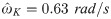
Evolution and statistics of phase metrics for two NA oscillators being (A) in- and (B) anti-phase synchronized.(a, b, h, i) Phase differences Δθ1,2(t), (black) and ϕ1,2(t), (red and magenta for significant PLV, and blue otherwise) with top plots zooming the shaded interval of the lower plots. (c, j) PLV (blue) and its mean value (black), and levels of significance (magenta and red). (d, k) Effective coupling strength, Keff (black) compared with the absolute value of the frequency difference, Δωeff, (blue if ω1 < ω2 and red otherwise), and (e, l) effective natural frequencies (red for ω1 and blue for ω2). (f, g, m, n) PDF (dashed red and full magenta line), histograms of phase differences during epochs of synchronization and their means (arrows). Parameters: ω1,2 = 12 ⋅ [1.03, 0.97] ⋅ 2π
rad/s, ϵ1,2 = [3.6, 3.6], ω^K=0.63rad/s, D = 5 (A) τ = 0.01s, ω^1,2=[0.48,0.74]rad/s, K = 25, ϵK = 5; (B) τ = 0.03s, ω^1,2=[0.42,0.60]rad/s, K = 30, ϵK = 6.